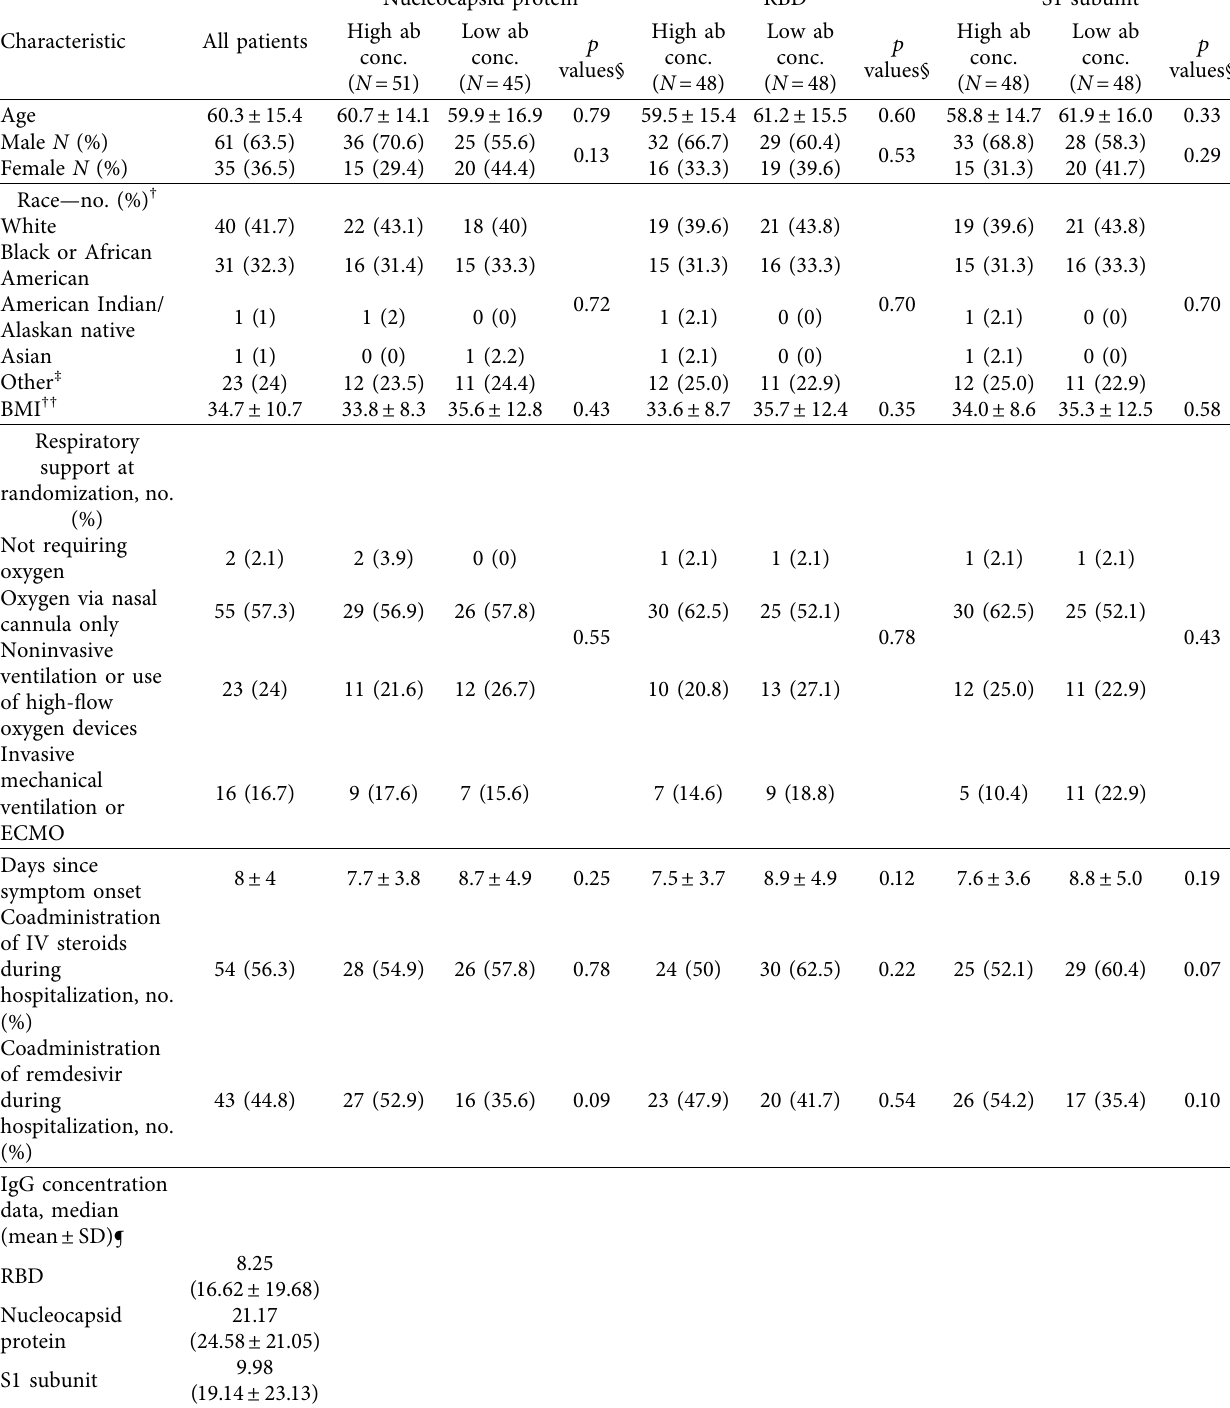
Table 1: Characteristics of participants at baseline for each antibody domain based on antibody concentration. Characteristic All